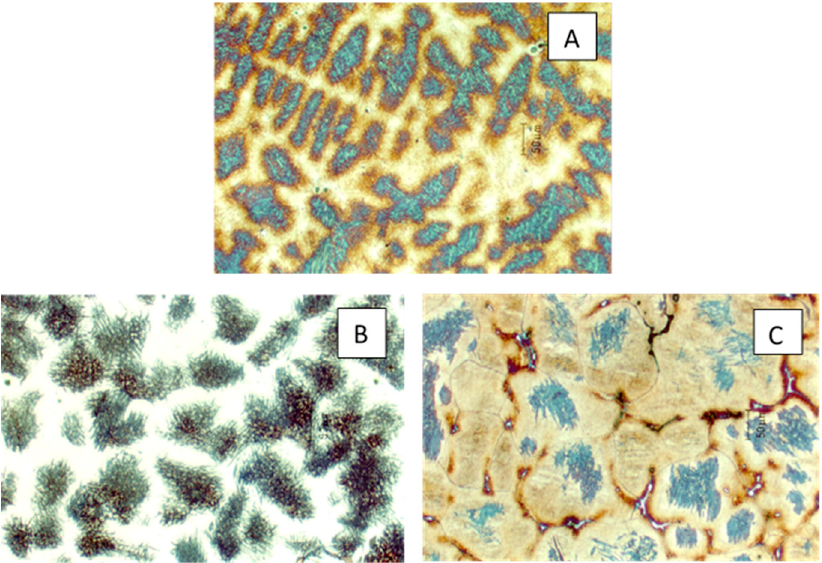
Figure 5. Examples of micrographs obtained after heat treatment: ( A ) casting 1, tempered at 150 °C; ( B ) casting 2, tempered at 550 °C; ( C ) casting 2, tempered at 850 °C.